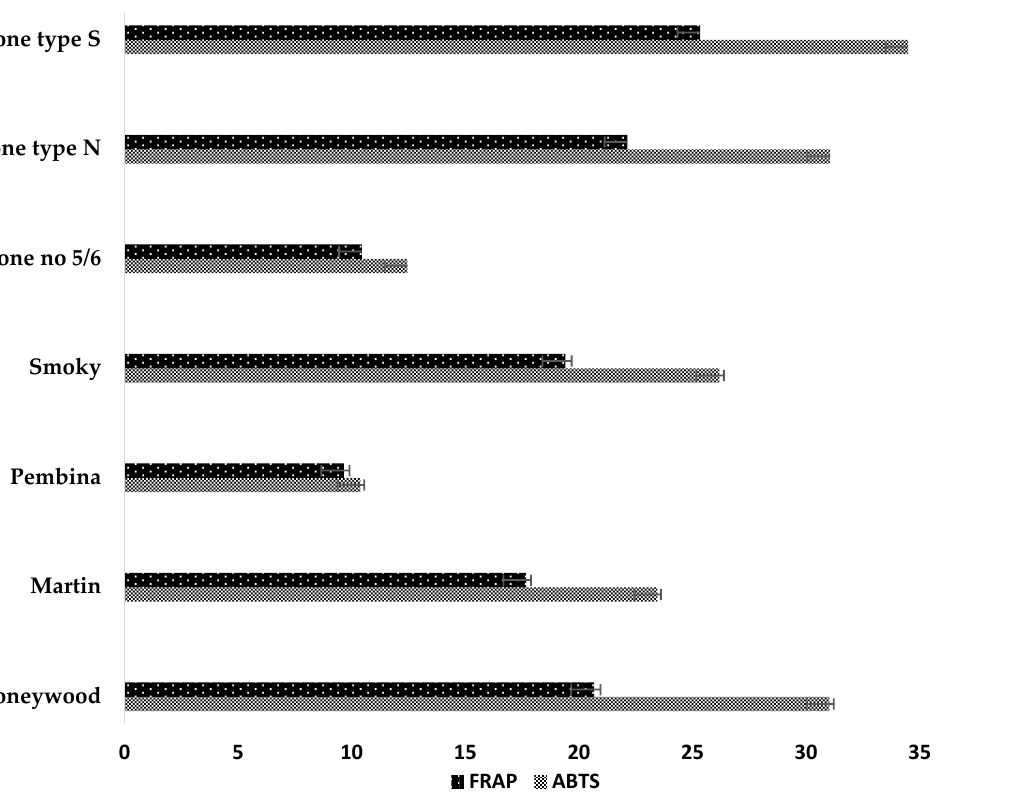
Figure 2. Antioxidant activity (mmol · Trolox/100 g · dm) 1 of different Saskatoon berry genotypes analyzed in 2016. 1 Values are means ± standard deviation. n = 3.